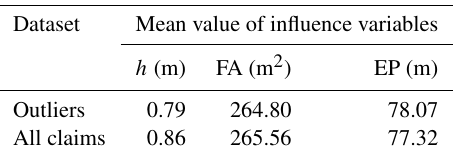
Table 6. Mean value of water depth ( h ), footprint area (FA), and external perimeters (EP) for all buildings with claims and for the outliers’ subset.